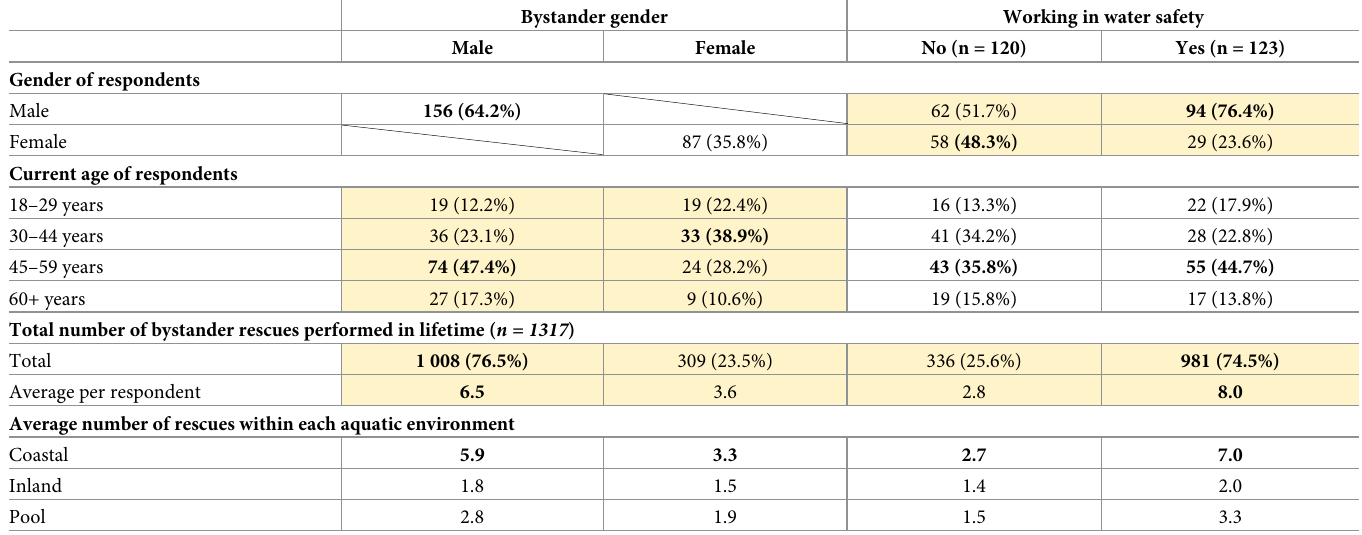
Table 2. Details about the bystander survey respondents at the time of completing the survey in relation to gender, age, number of rescues performed/type of water- way and if they were working in water safety. The total survey sample size was n = 243. Values in bold represent maximums for relevant categories. Shaded areas were found to be statistically